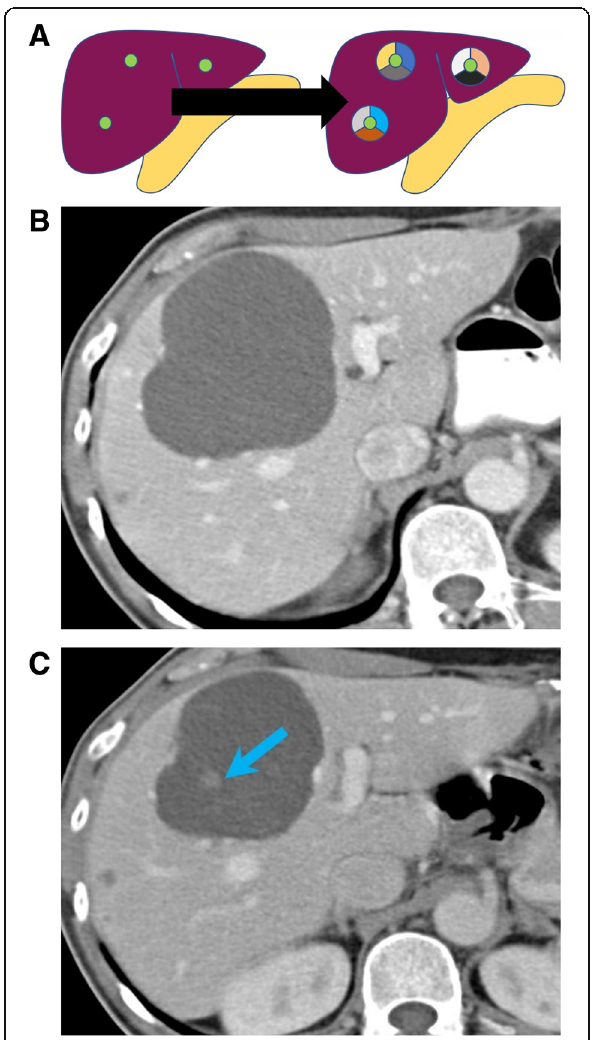
Fig. 9 Intrametastatic heterogeneity. a Image exemplifying the development of heterogeneity among the cells the liver metastases as the metastases grow (black arrow). Axial CT images acquired during portal venous phase ( b , c ) in a 77-year-old woman with gastrointestinal stromal tumor acquired during treatment with imatinib. The hypodense metastasis in the liver shows a new intralesional soft tissue nodule at follow up scan (arrow) ( c ), suspicious for recurrence